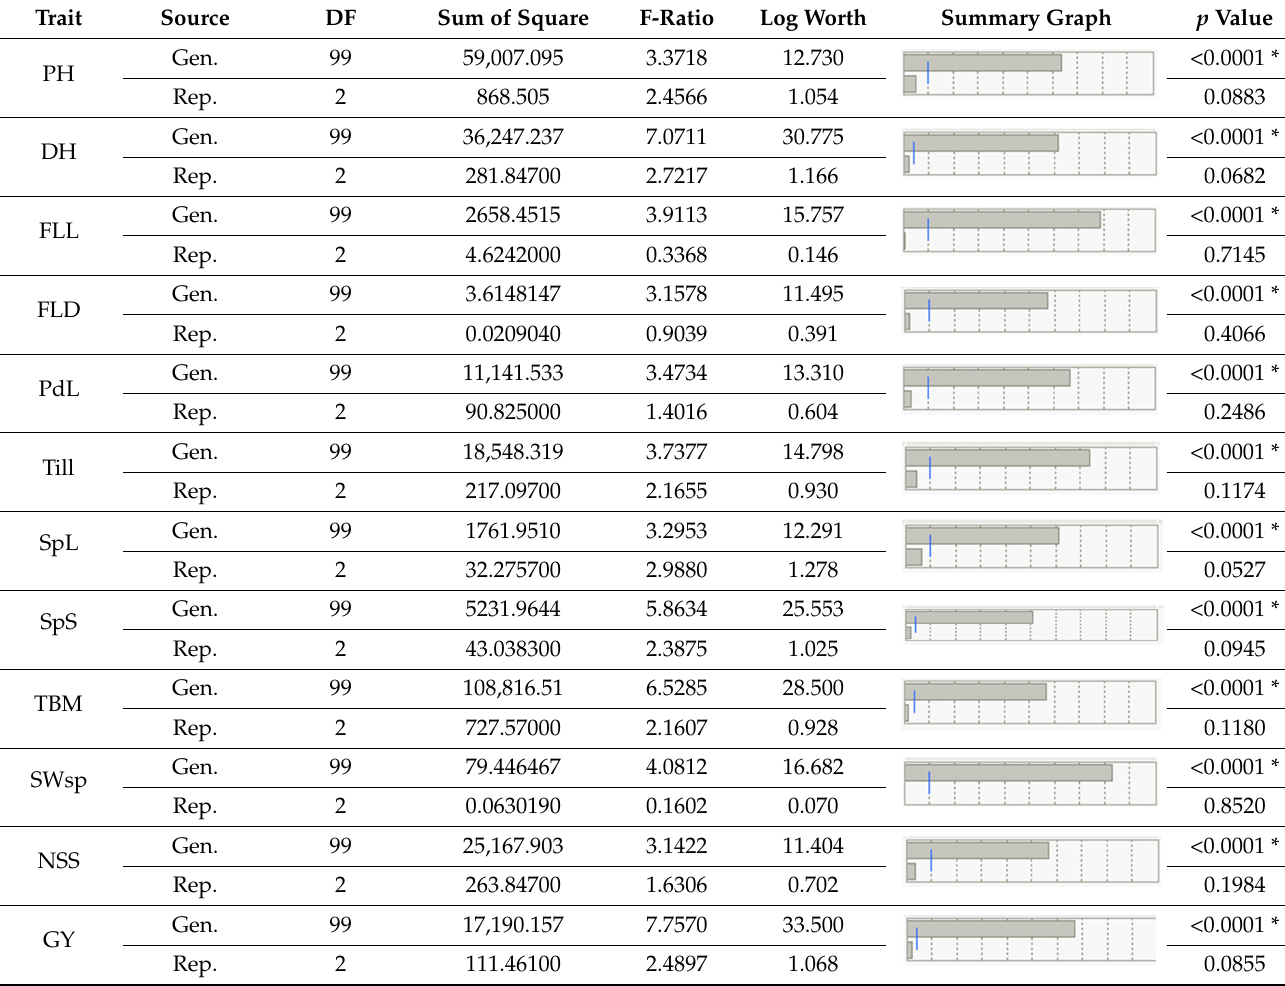
Mean Average value, Std. Dev: standard deviation, Min: minimum value, Max: maximum value. PH: plant height, DH: days to heading, FLL: flag leaf length, FLD: flag leaf diameter, PdL: peduncle length, Till: tillers per plant, SpL: spike length, SpS: number of spikelets per spike, TBM: total biomass, SWsp: Seed Weight per Spike, NSS: number of seeds per spike, GY: grain yield.